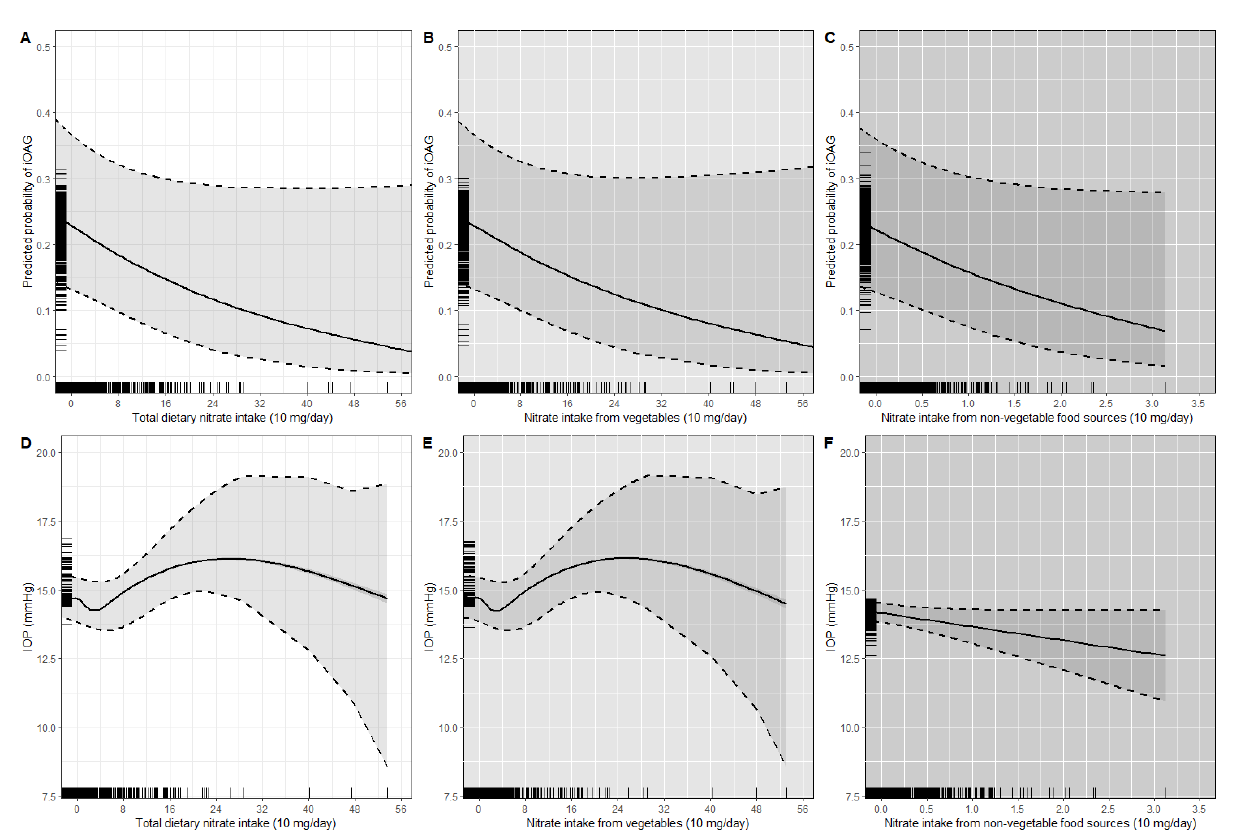
Figure 1. Graphic presentation of the multivariable-adjusted dose–response relationship between incident open-angle glaucoma (iOAG), intraocular pressure (IOP), and energy adjusted dietary nitrate intake obtained by generalized additive regression models; total dietary nitrate intake ( A , D ), nitrate intake from vegetables ( B , E ), and nitrate intake from non-vegetable food sources ( C , F ). Dotted lines represent 95% confidence intervals. The reference value is the value associated with the mean nitrate intake for all participants. The rug plot along the x - and y -axis of each graph depicts each observation. In the multivariable-adjusted model (Figure 2A; model 1), each 10 mg/day higher total dietary nitrate intake was associated with a 5% reduction in the risk of iOAG (OR (95% CI): 0.95 (0.91 – 0.98)). Participants in the highest quintile (Q5: mean 213.0 mg/day) had the largest risk reduction (OR (95% CI): 0.38 (0.20 – 0.72)) compared to participants in the lowest quintile (Q1: mean 48.8 mg/day) ( p -trend = 0.002). For nitrate intake from veg- etables, we observed a 5% reduction in the risk of iOAG (OR (95% CI): 0.95 (0.91 – 0.98)) for each 10 mg/day higher intake (Figure 2B; model 1). The difference in iOAG risk was 61% when comparing the highest (Q5: mean 196.8 mg/day) and lowest (Q1: mean 34.6 mg/day) nitrate intake from vegetables (OR (95% CI): 0.39 (0.20 – 0.73)) ( p -trend = 0.003). For nitrate intake from non-vegetable food sources, we observed a 37% reduction in the risk of iOAG (OR (95% CI): 0.63 (0.41 – 0.96)) for each 10 mg/day higher intake (Figure 2C; model 1), but